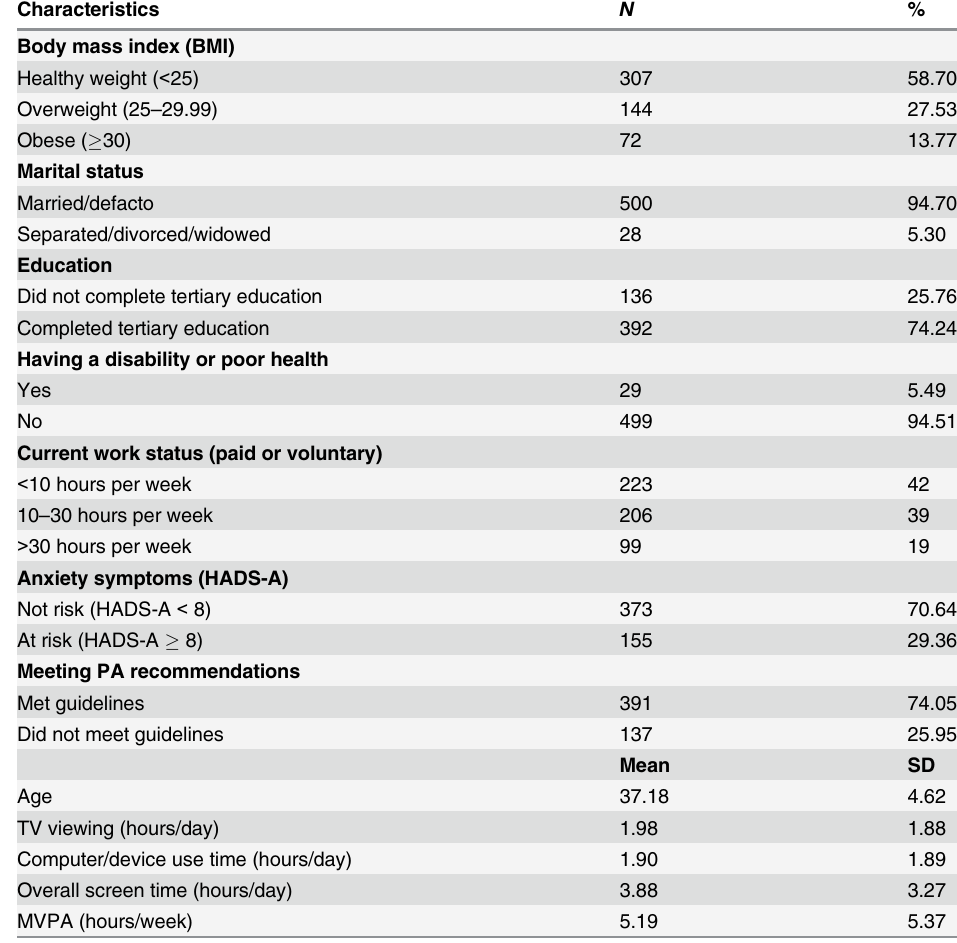
Table 1. Socio-demographic characteristics of women (n = 528).